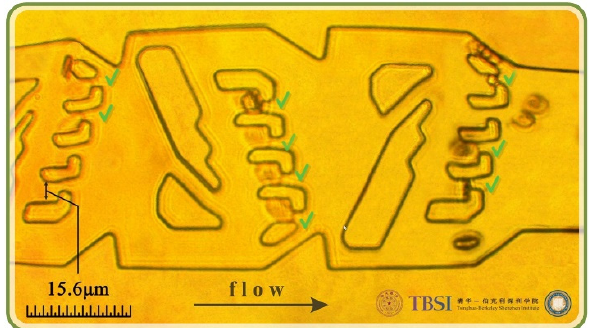
Figure 6. Experimental results of the prototype system following the evolutionary algorithm design to trap RBCs. Three consecutive chambers are designed to trap RBCs. Green “V”s mark the successfully trapped cells in each slot.